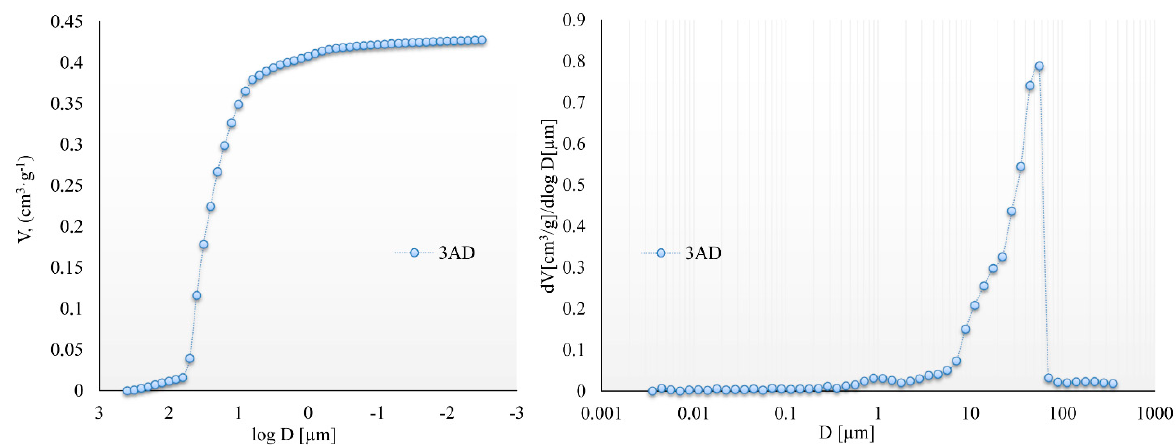
Figure 5. The cumulative and differential curves obtained for powdered